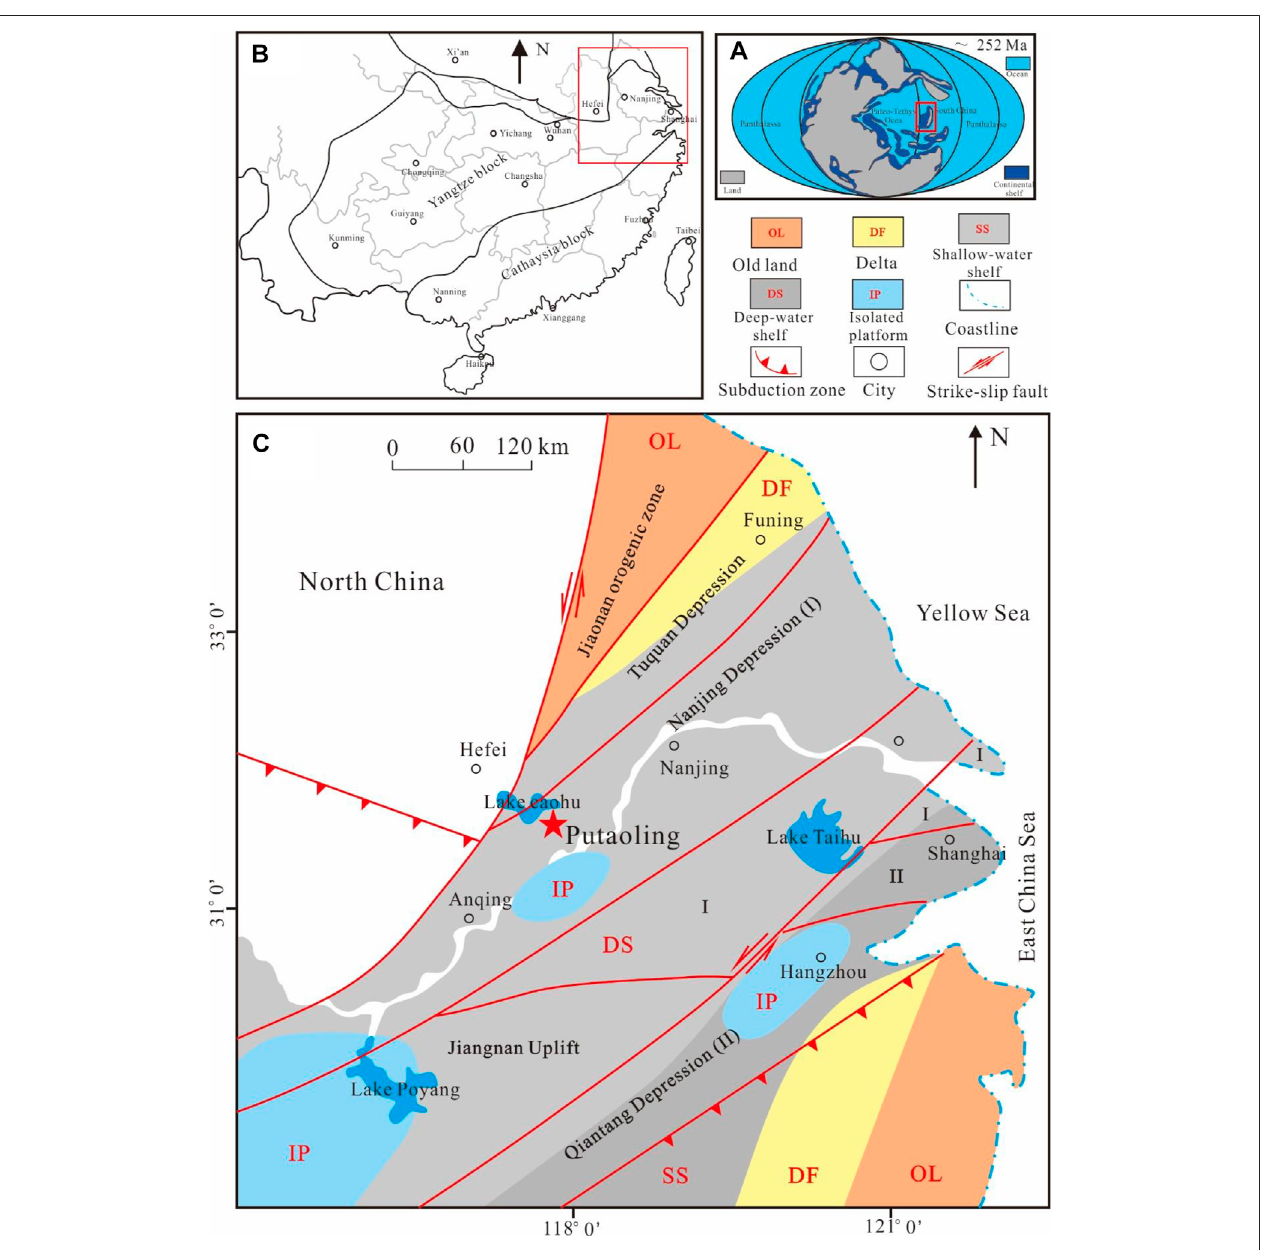
FIGURE 1 | (A) Late Guadalupian palaeogeography and the relative location of South China [modi fi ed from Liu and Selby (2021)]. (B) Tectonic division map of South China and the location of the Lower Yangtze area. (C) Location map of the studied area showing the middle Permian tectonic units and facies distribution. The sampling Putaoling section can be seen [modi fi ed from Bai et al. (2021) and Ding et al. (2021)].